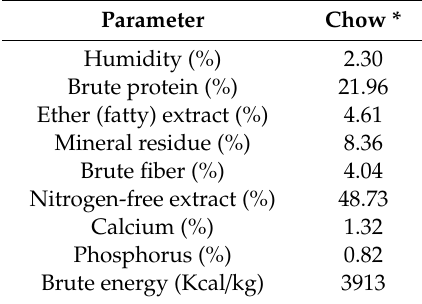
Table 1. Nutritional composition of the chow used in the experiment for all animals. Ad libitum feeding of